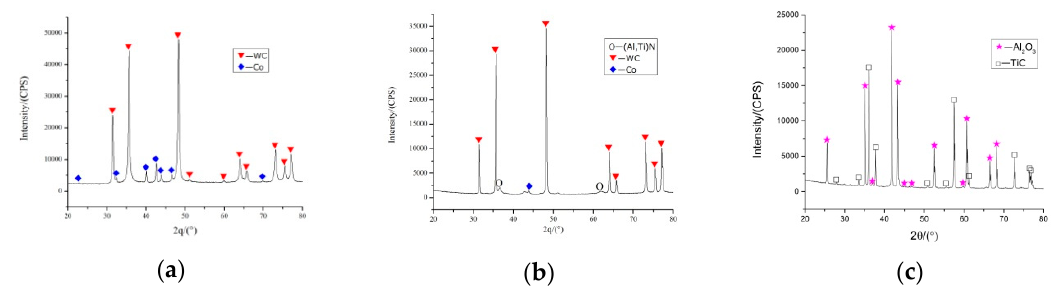
Figure 10. XRD patterns of the tool material at 1273 K. ( a ) WC/Co, ( b ) coated carbide, and ( c ) ceramic.